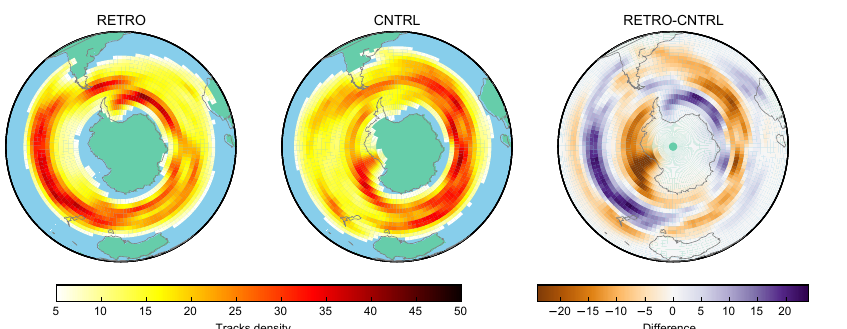
Figure E2. As in Fig. 4 but for the Southern Hemisphere during the JJA season.